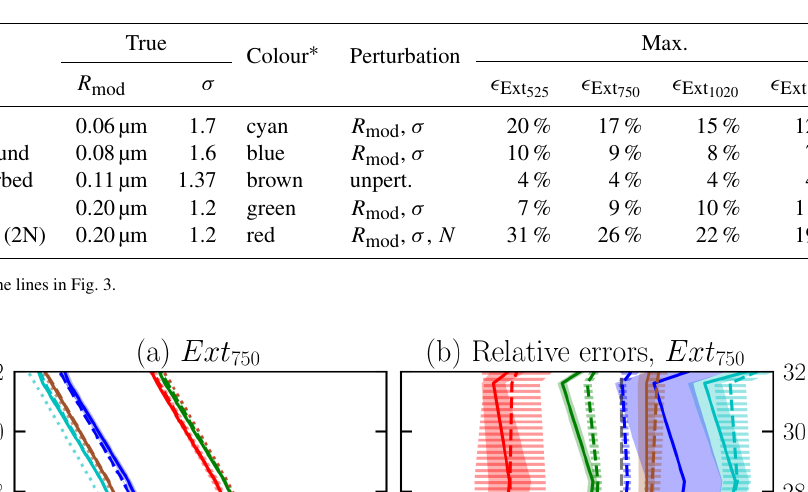
Table 1. Selected scenarios and associated maximum relative parameter errors in the calculated extinction coefficients.